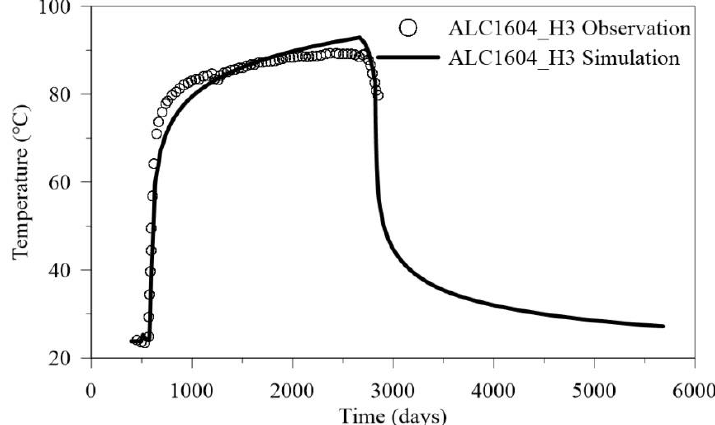
Figure 9. Casing temperature evolution obtained by numerical simulation in comparison with the